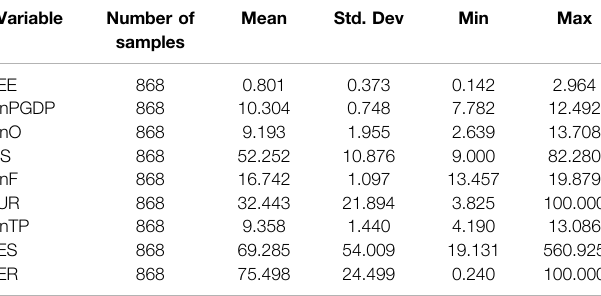
TABLE 3 | Descriptive statistics of factors in fl uencing ecological ef fi ciency in the Yellow River